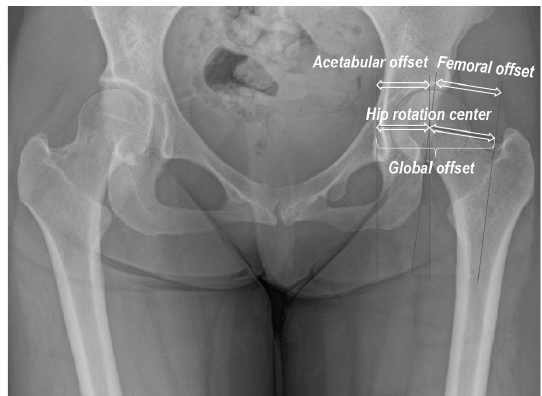
Figure 1. Radiographic hip morphometric parameters analyzed in this study.